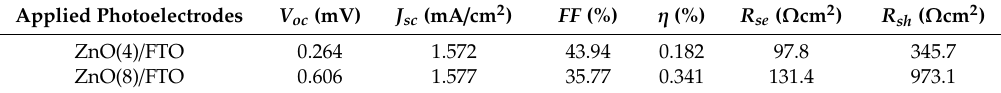
Figure 5. J – V characteristics of DSSCs with ZnO(4) / FTO and ZnO(8) / FTO photoelectrodes. Table 1. Photovoltaic properties of DSSCs with ZnO(4) / FTO and ZnO(8) / FTO photoelectrodes.